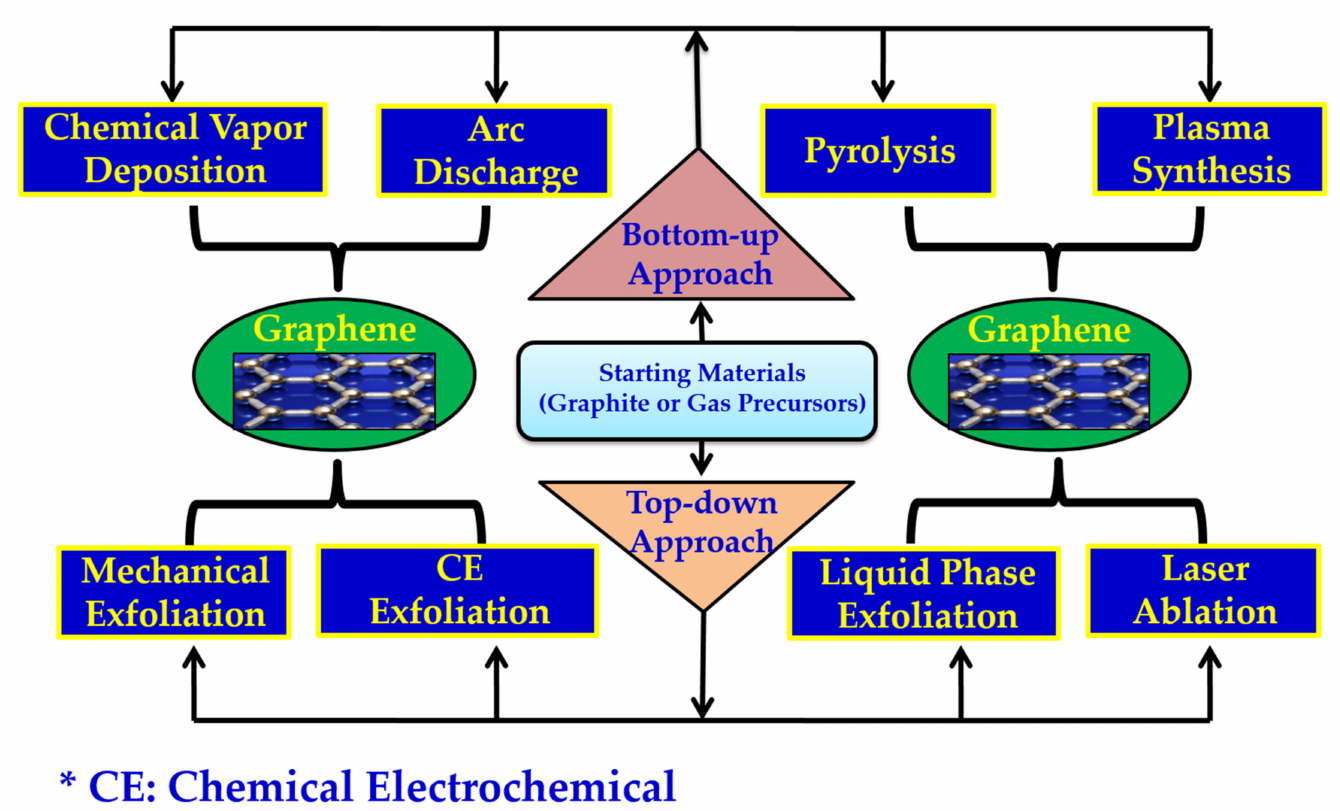
Figure 3. Schematic representation of the general methods for graphene